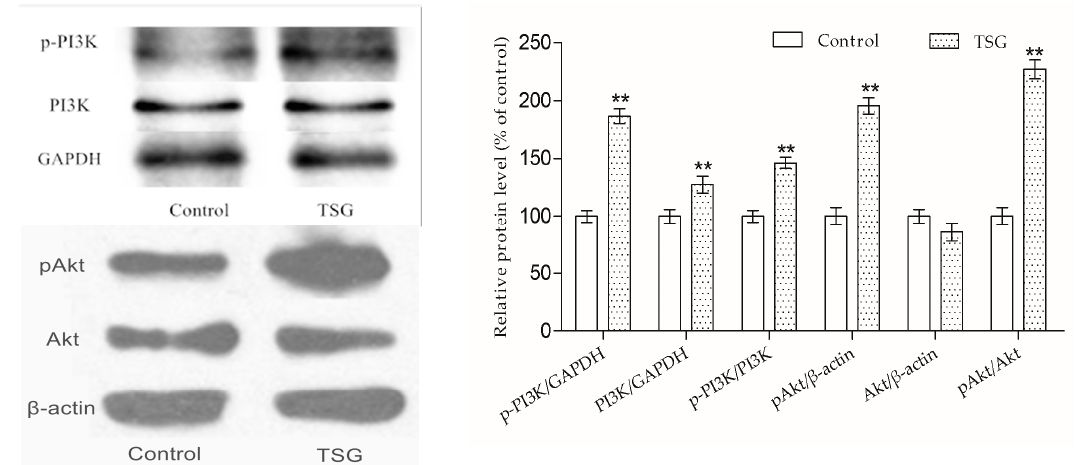
Figure 6. Effect of TSG on the p-PI3K, PI3k, pAkt, and Akt protein levels. Data are represented as the mean ± SD of three determinations. ** p < 0.01 when compared with the control group.